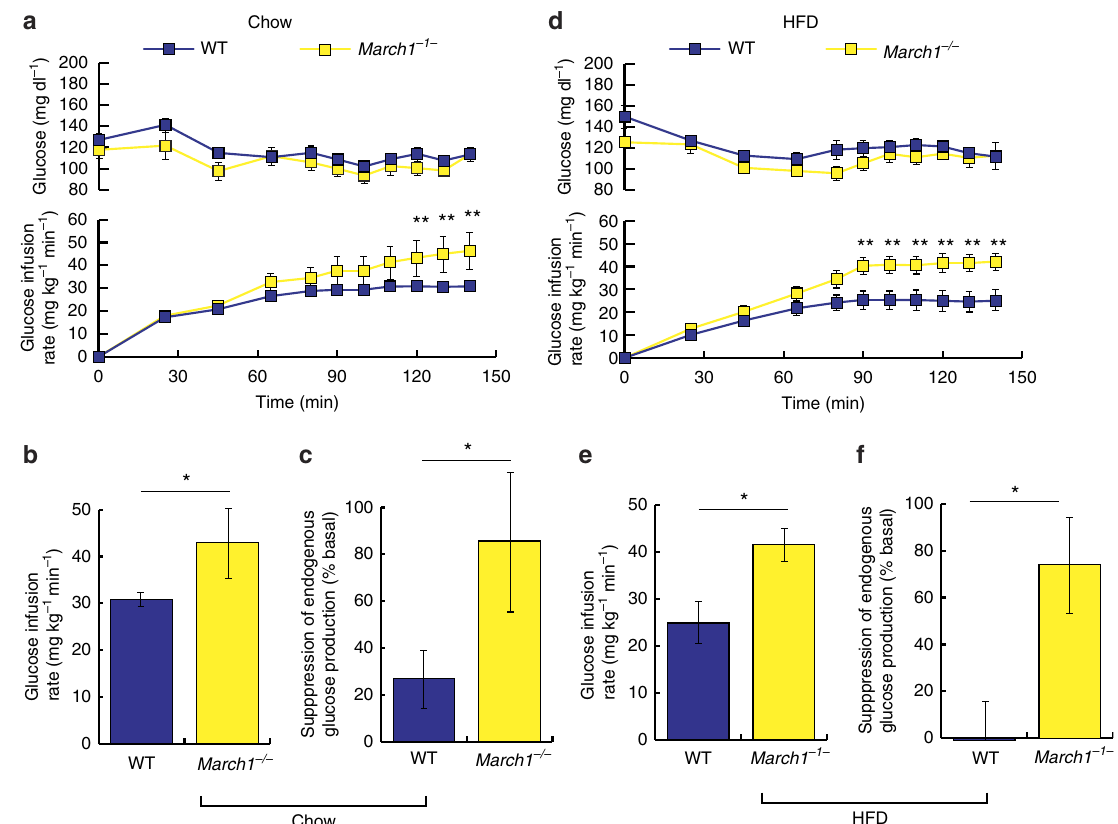
Figure 4 | March1 (cid:2) / (cid:2) mice display improved hepatic insulin action. Littermate wild-type control mice were used in all studies of March1 (cid:2) / (cid:2) mice. Different insulin infusion rates were used for studies of chow-fed and HFD-fed mice (2 and 3mUkg (cid:2) 1 min (cid:2) 1 , respectively), so data are not superimposed. ( a ) Plasma glucose and glucose infusion rates during hyperinsulinemic-euglycemic clamp studies in male mice fed regular chow. ( b ) Mean steady-state glucose infusion rates in chow-fed male mice. ( c ) Insulin suppression of EGP in chow-fed male mice, expressed as % basal EGP. ( d ) Plasma glucose and glucose infusion rates during hyperinsulinemic-euglycemic clamp studies in male mice fed HFD for 3 weeks. ( e ) Mean steady-state glucose infusion rates in HFD-fed male mice. ( f ) Insulin suppression of EGP in HFD-fed male mice. Data are mean ± s.e.m. In all panels, * P o 0.05, ** P o 0.005. All comparisons by two-tailed unpaired t -test. In a – c , n ¼ 10 WT and five knockout mice per group. In d – f , n ¼ 5 mice per